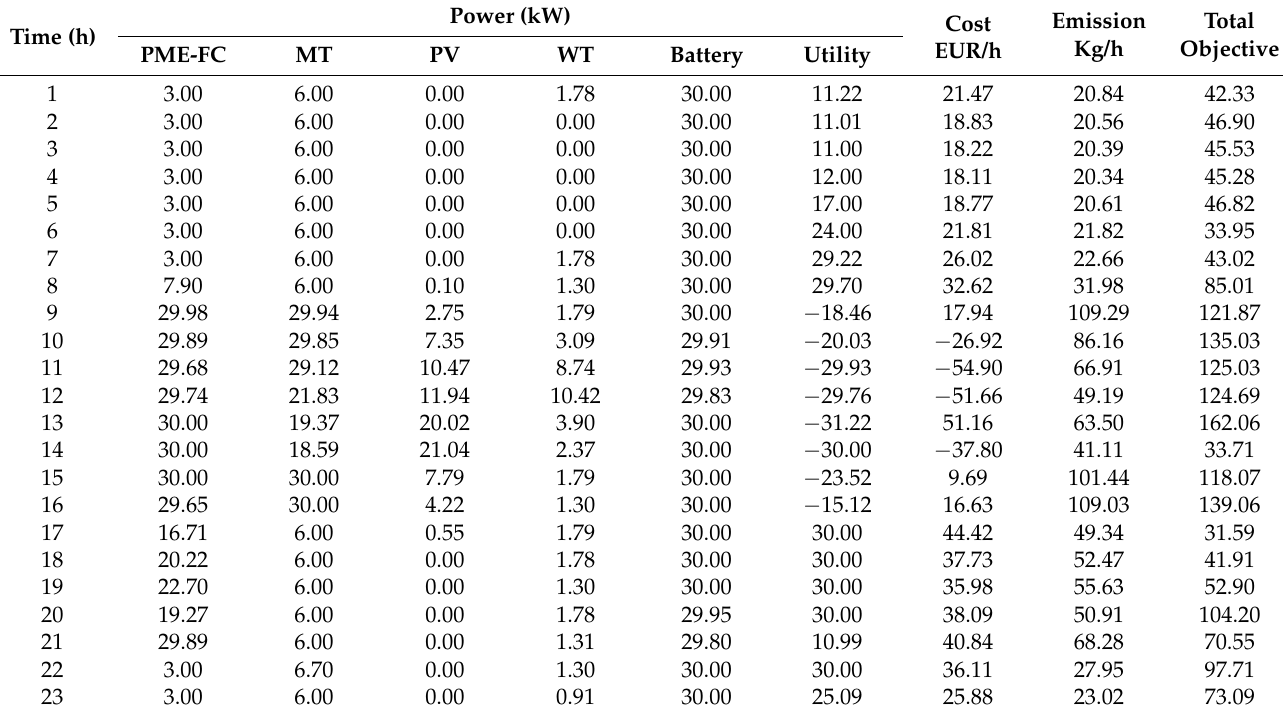
Table 5. The Best results obtained using EO for the EM problem for Scenario 2 (Case